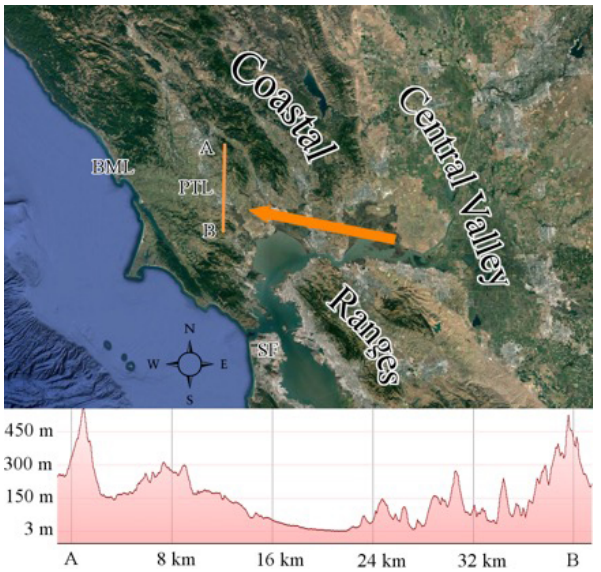
Figure 1. Regional map displaying the location of BML, the town of Petaluma, CA (PTL); San Francisco, CA (SF); the Central Valley; and the Coastal Ranges. The orange arrow depicts the direction of typical flow during PGF conditions. Line A–B traces a path across the Petaluma Gap. The inset at bottom displays the cross-gap terrain profile along line